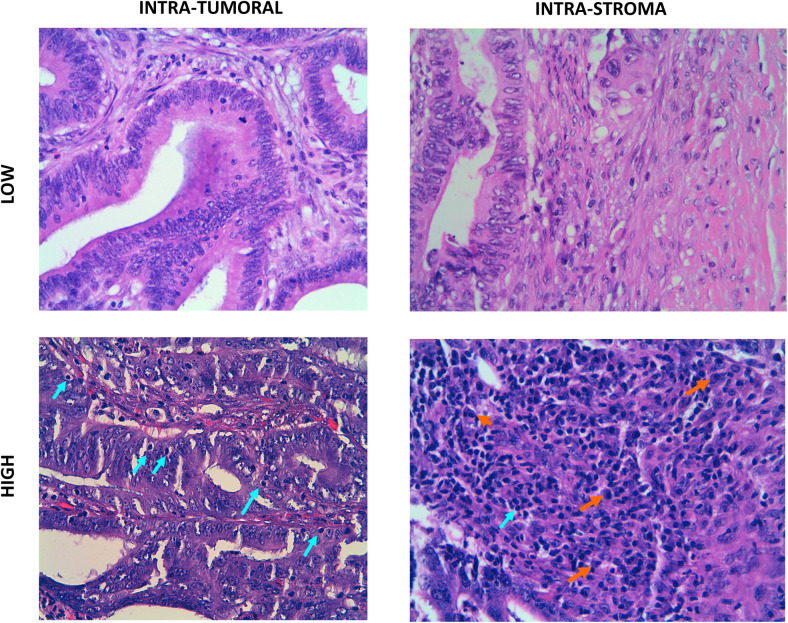
Examples of pathologist-based quantification of lymphocytes in HE slides.A. Low intraepithelial TILs. HE staining 400×. B. Low STL. HE staining 400×. C. High intraepithelial TILs. HE staining 400x. Intraepithelial lymphocytes (arrow). D. High STLs. HE staining 400×. Lymphocytes (green arrow). Plasma cells (orange arrow). HE, hematoxylin and eosin; STL, stromal lymphocyte; TIL, tumor-infiltrating lymphocyte.